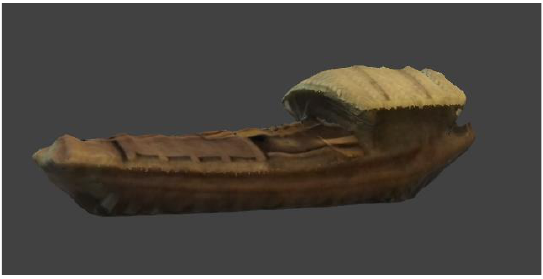
Figure 3. Small Junk Model being scanned with Qlone App on Samsung Galaxy S6 Cell Phone